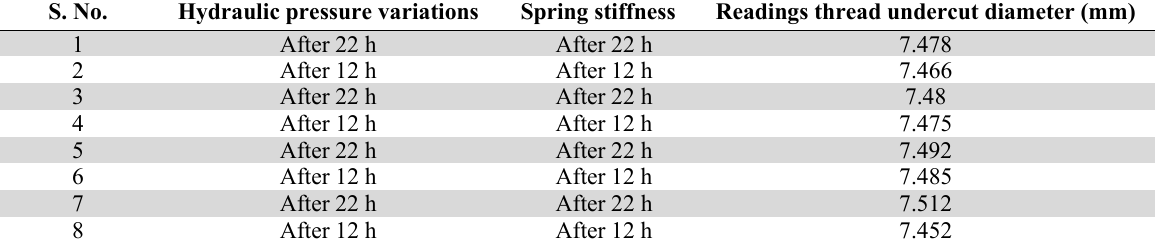
Readings of significant factors at various levels S.